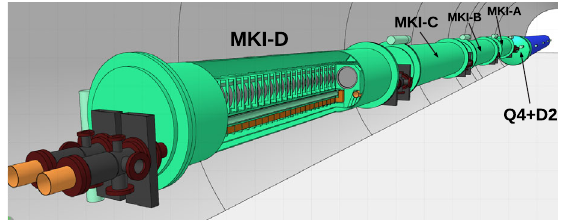
FIG. 12. Geometry model of the four injection kickers (MKIs) and the downstream cryounit, containing the D2 dipole and the Q4 quadrupole. The first kicker module (MKI-D) is cut open to show the